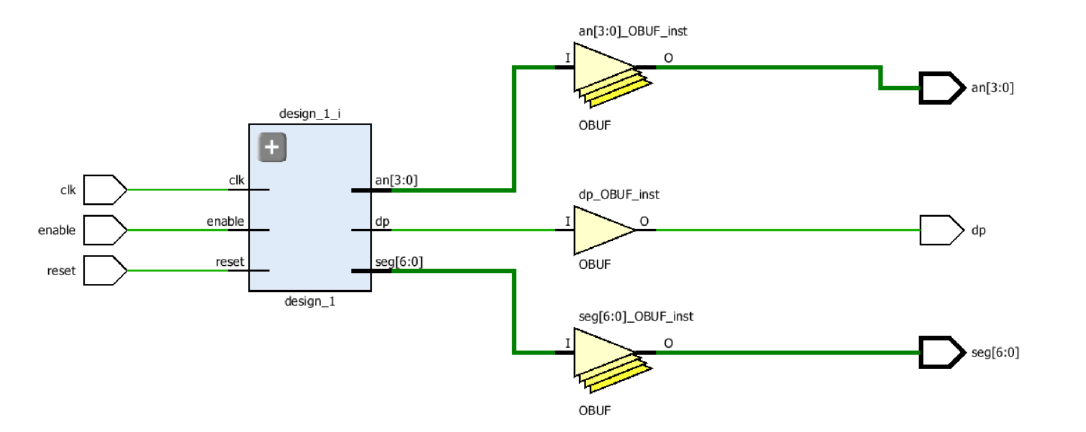
Figure 2. Trojan-free Elaborated Design Schematic Provided by